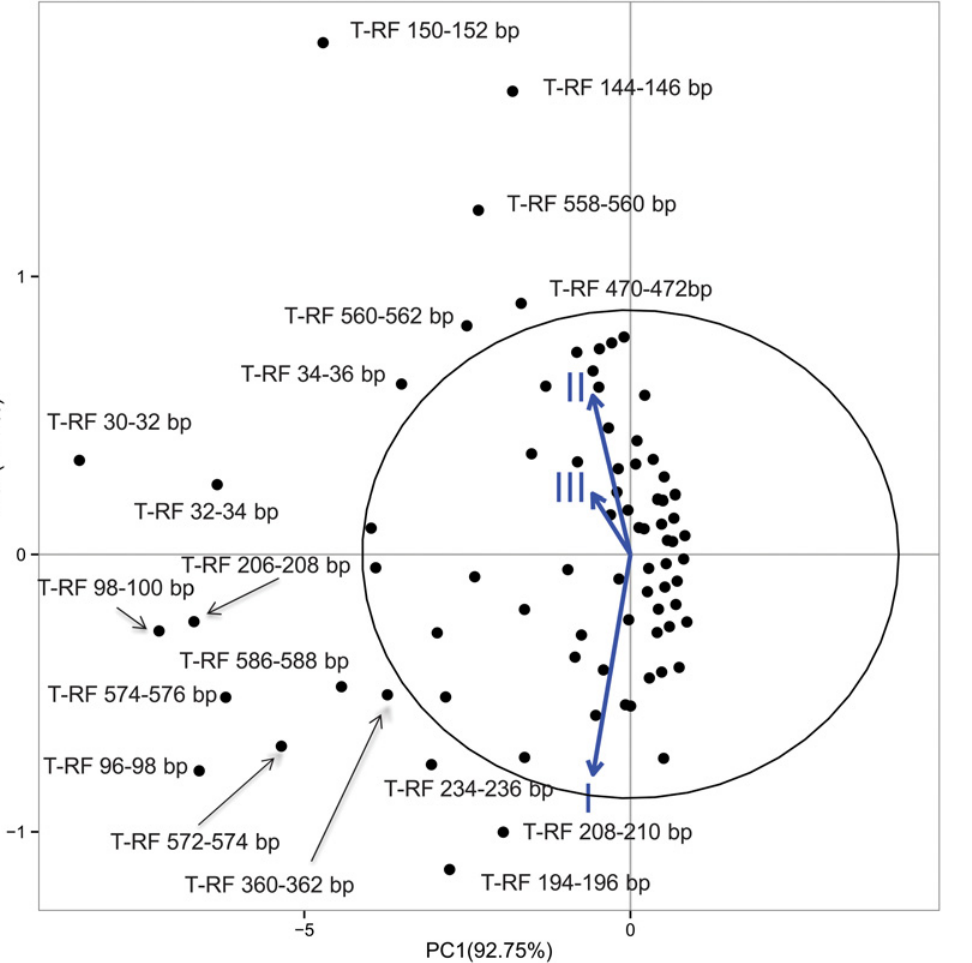
Fig 4. PCA of total occurrences of T-RFs in CF patients showing comparison among the FEV 1 groups. Ellipse with 95% is reported. The numbers on the axes indicate the amount of variance explained by each component. The labels outside the 95% ellipse have been jittered to avoid overlaps. Black circles represent T-RFs. Are indicated those T-RFs, ouside the ellipse, that are significantly associated to the PC1 and PC2.